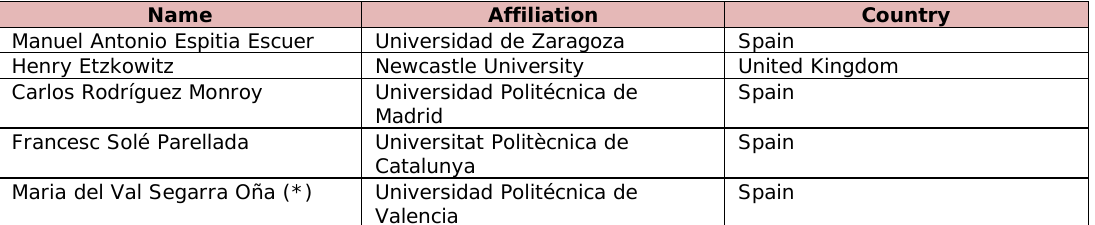
Table 5. “List of members of JIEM editorial board in 2009 (Industrial Economics and Regional Development). Members added in 2009 are marked with asterisk”. Source: editors.